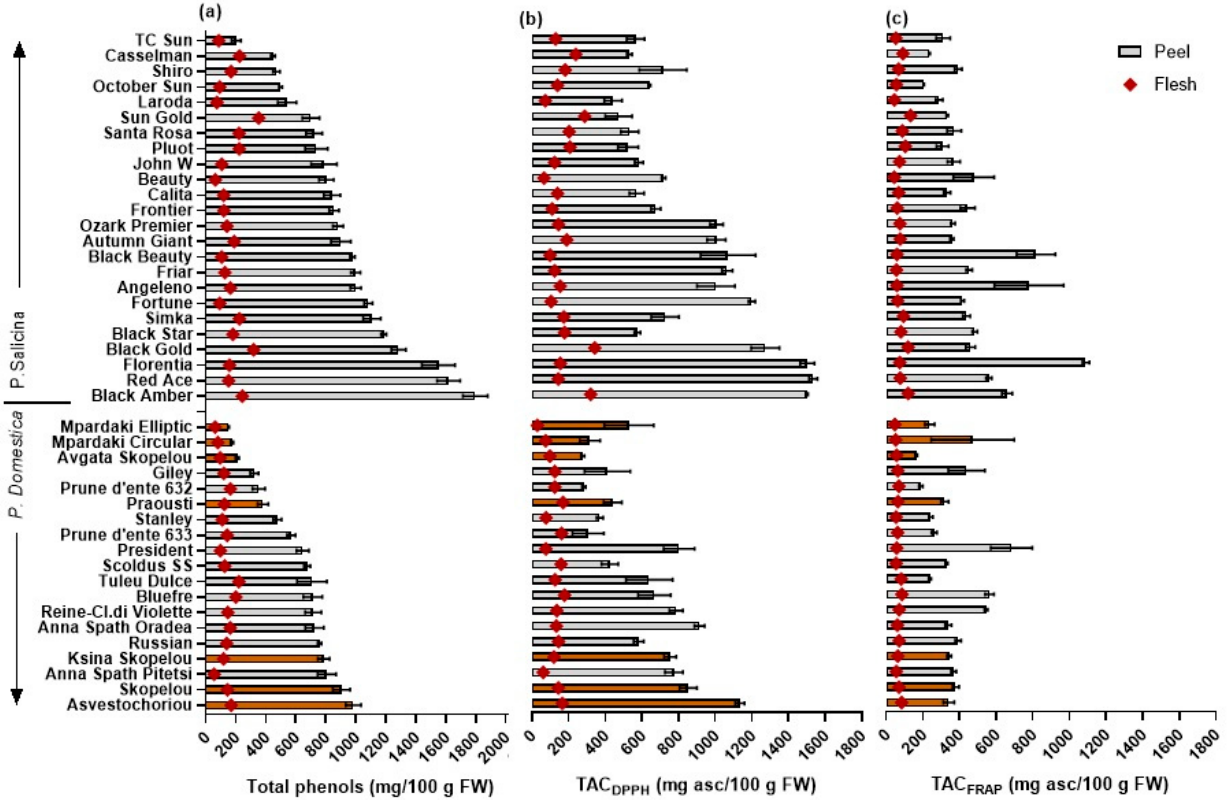
Figure 2. Mean ( ± SE) ( a ) total phenol content (mg gallic acid equivalent/100 g FW), ( b ) total antioxidant capacity using the DPPH (TAC DPPH ), and ( c ) the FRAP radical (TAC FRAP ) (mg ascorbic acid equivalent/100 g FW), in fruit peel (solid bars) and flesh (rhombus) tissue of 43 European and Japanese plum cvs. Colored columns represent local cultivars. LSD: TPs–peel, 143.5; TPs–flesh, 40.5; TAC DPPH –peel, 181.1; TAC DPPH –flesh, 38.3; TAC FRAP –peel, 172.4; TAC FRAP –flesh, 15.9.